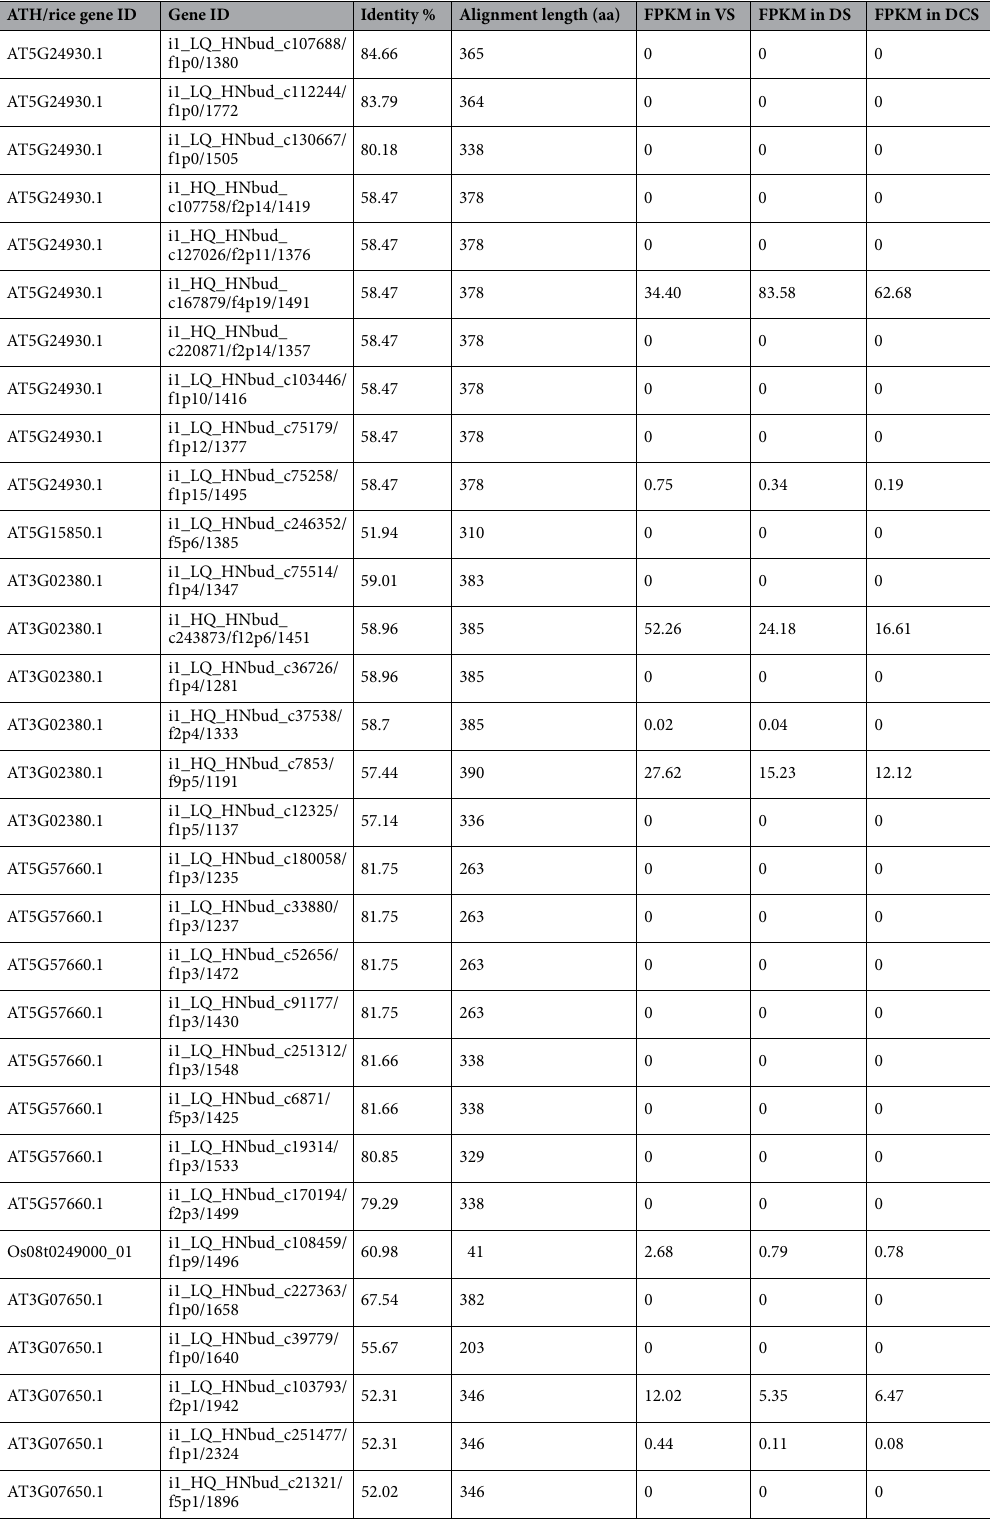
Table 2. The CO genes identified in ’High